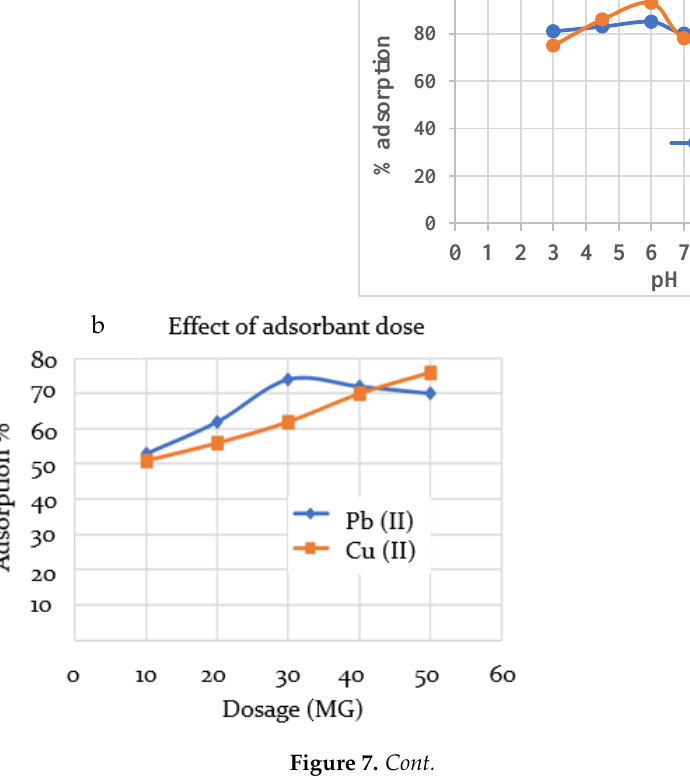
Figure 7. The effect of ( a ) pH on adsorption efficiency (time 30 min, temperature 25 °C, adsorbent dose 50.0 mg, metal ion concentration 30.0 mg, and solution volume 10.0 mL), ( b ) adsorbent dose (CMOISW) (time 30 min, temperature 25 °C. pH 6.0, metal ion concentration 30.0 mg, and solution volume 10.0 mL), ( c ) metal initial concentration (time 30 min, temperature 25 °C, adsorbent dose 50.0 mg, pH 6.0, and solution volume 10.0 mL), ( d ) temperature (time, 30 min, temperature 25 °C, adsorbent dose 50.0 mg, metal ion concentration 30.0 mg, and solution volume 10.0 mL), and ( e )